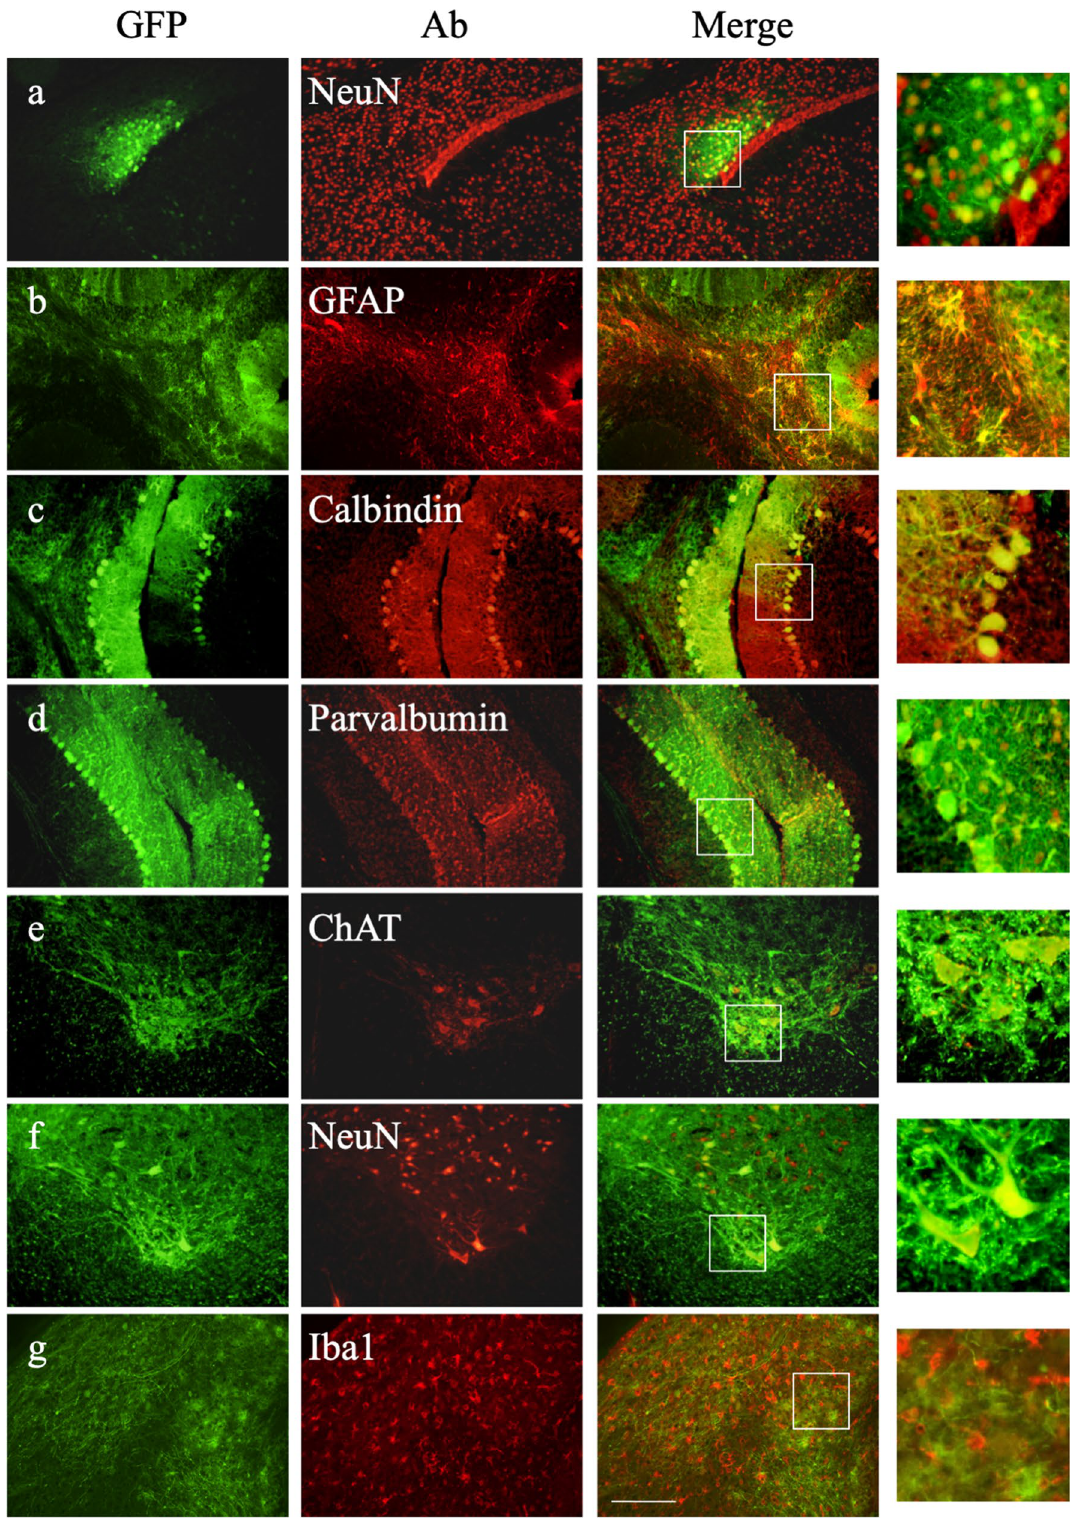
Figure 3. Immunohistochemical analysis of transduced cells in the brain and spinal cord of treated MLD mice at 1 year of age. Immunostaining for GFP and the neuronal marker NeuN ( a ), the astrocyte marker GFAP ( b ), the Purkinje marker calbindin ( c ), the basket marker parvalbumin in the cerebellum ( d ), the microglia marker Iba1 ( g ) in the brain, and ChAT-positive motor neurons ( e ) and NeuN-positive neurons ( f ) in the cervical spinal cord, especially the ventral horn. Bar: 200 μM. Panels on the right highlight the observed